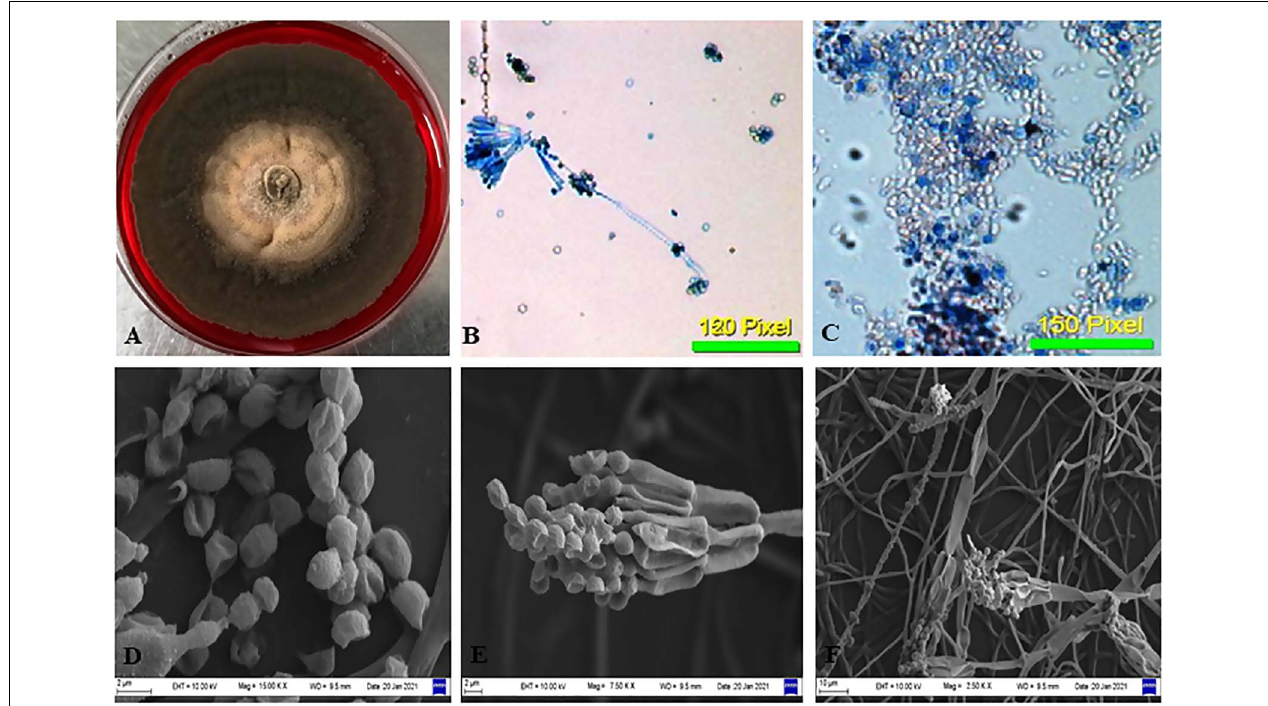
FIGURE 3 | Morphological examination of the isolate CPEF04 from Avicennia marina . (A) Obverse of colonies of CPEF04. (B,C) Light micrographs of the conidiophores and conidia of isolate CPEF04. (D–F) SEM of the structures of the strain CPEF04. (D) Conidia and (E) structure of the conidiophore. (F) Surface of the